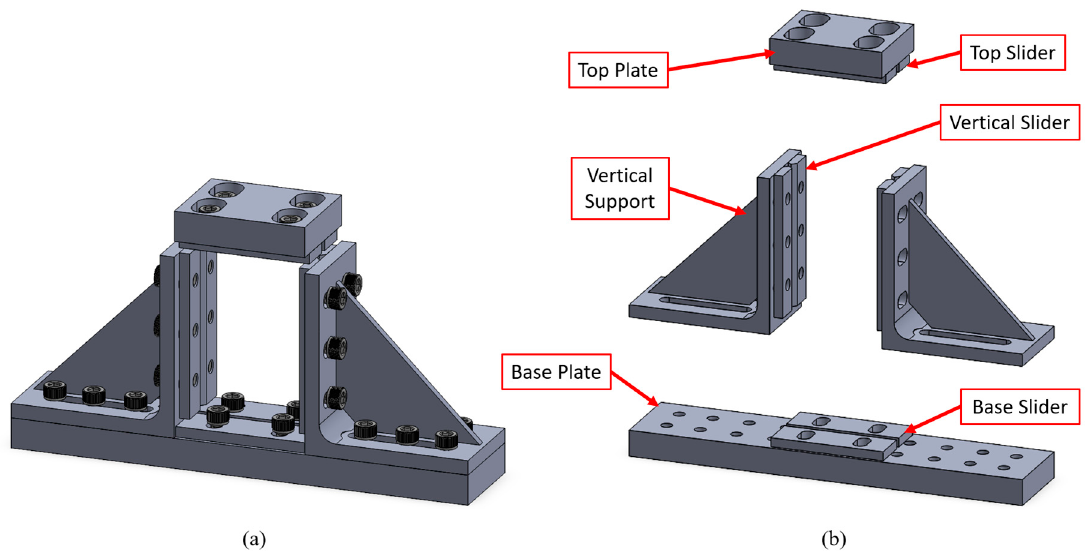
Figure 3. CAI fixture ( a ) assembled; ( b ) exploded Figure 3. CAI fi xture ( a ) assembled; ( b ) exploded view.